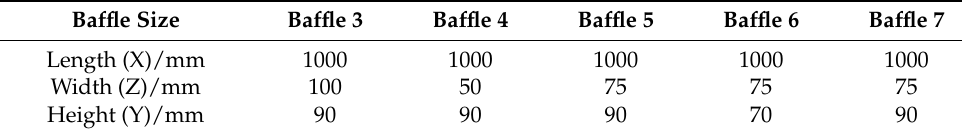
Figure 19. Stress load on the bottom of main troughs with different widths and depths.